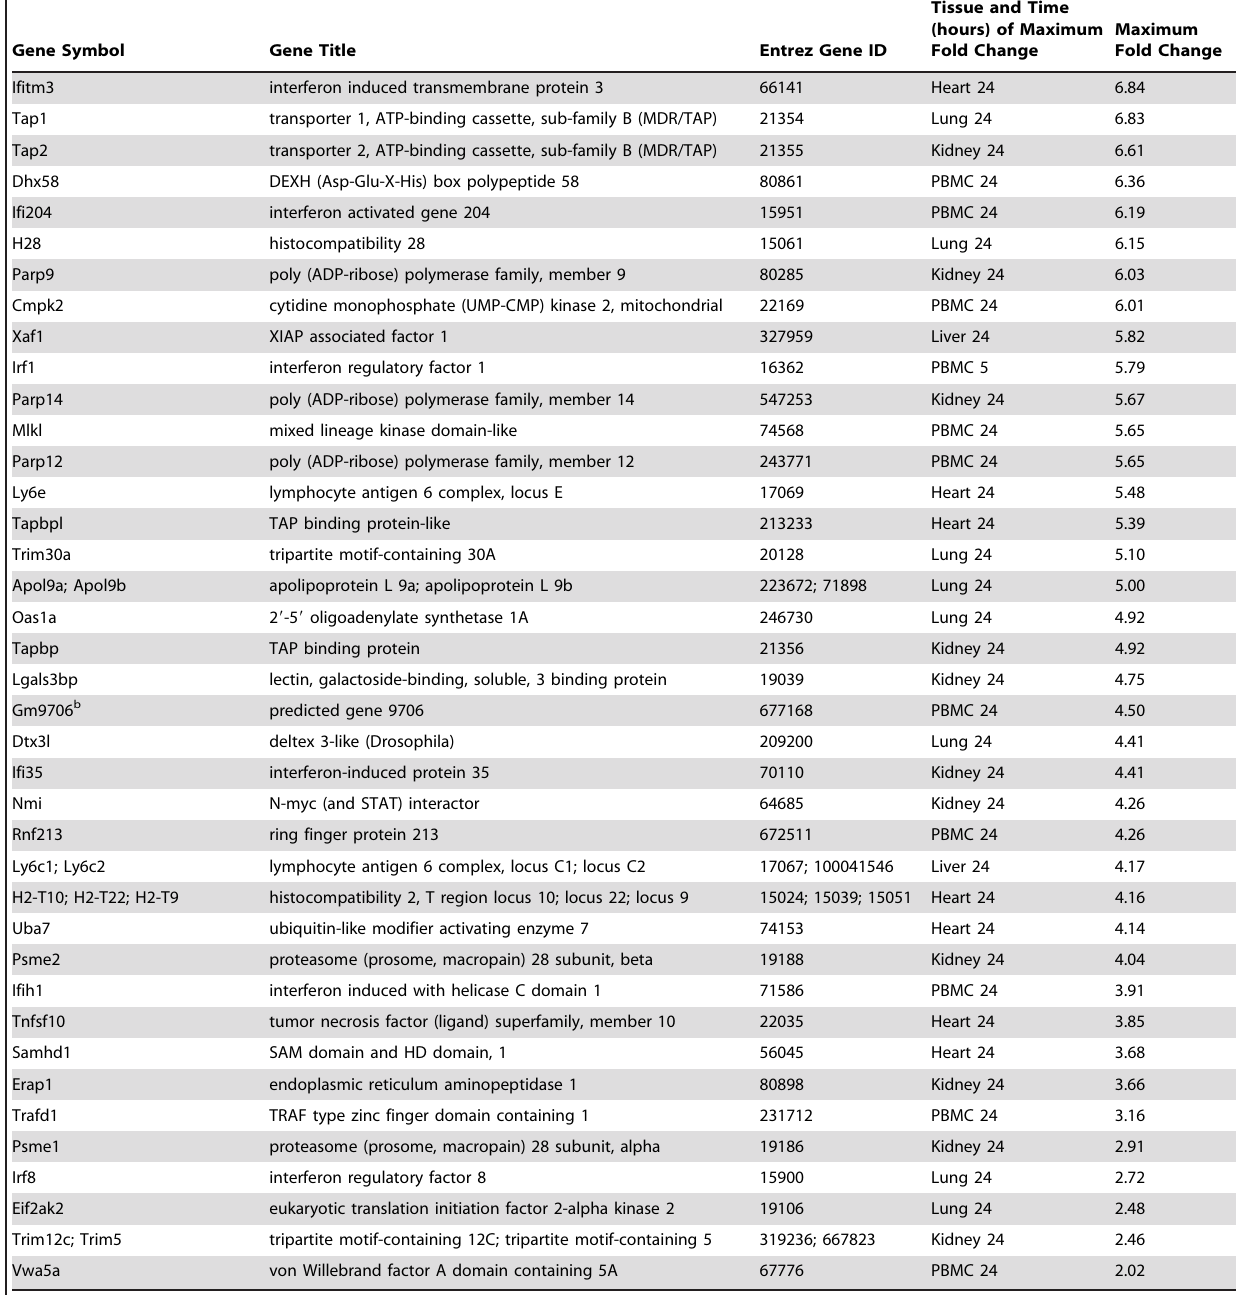
von Willebrand factor A domain containing 5A Genes are ordered by maximum fold change from baseline. For two or more probesets annotated to the exact same gene and Entrez ID, results are only shown for the probeset with the largest fold-change. Three probable duplicate entries, with tentative annotations and more than one Entrez ID number, are designated (a, b, c, respectively), leaving a total of 82 unique genes. Tissue and time in hours of maximum fold changes are shown. Multiple probesets for the same gene occasionally showed more than two fold differences in maximum fold-change, but did not differ by tissue or time point of peak